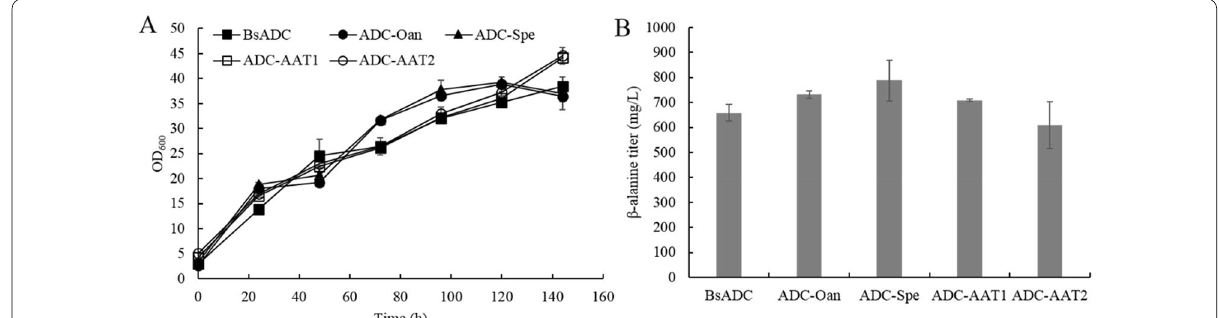
Fig. 4 The effects of overexpression of AAT or AspDH on β-alanine production. A Growth profiles of recombinant strains; B β-alanine production in recombinant strains at the end of fermentation. Three parallel flasks are tested for each strain. Error bars represent deviations ( n